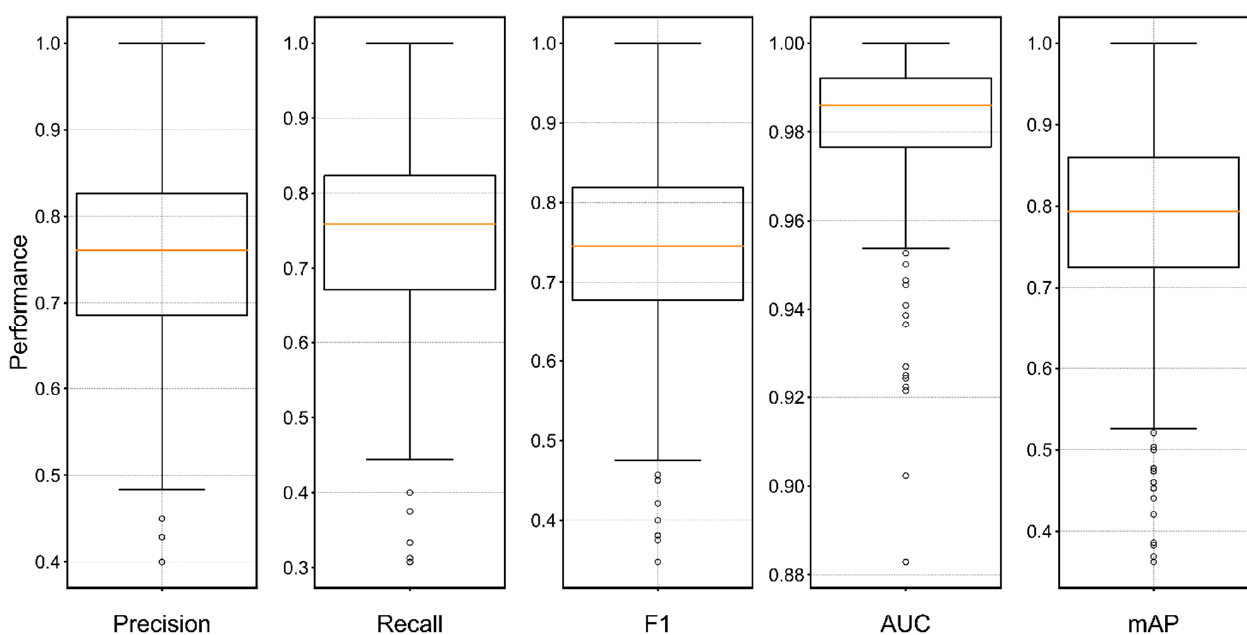
Figure 8. Performance of the proposed model.